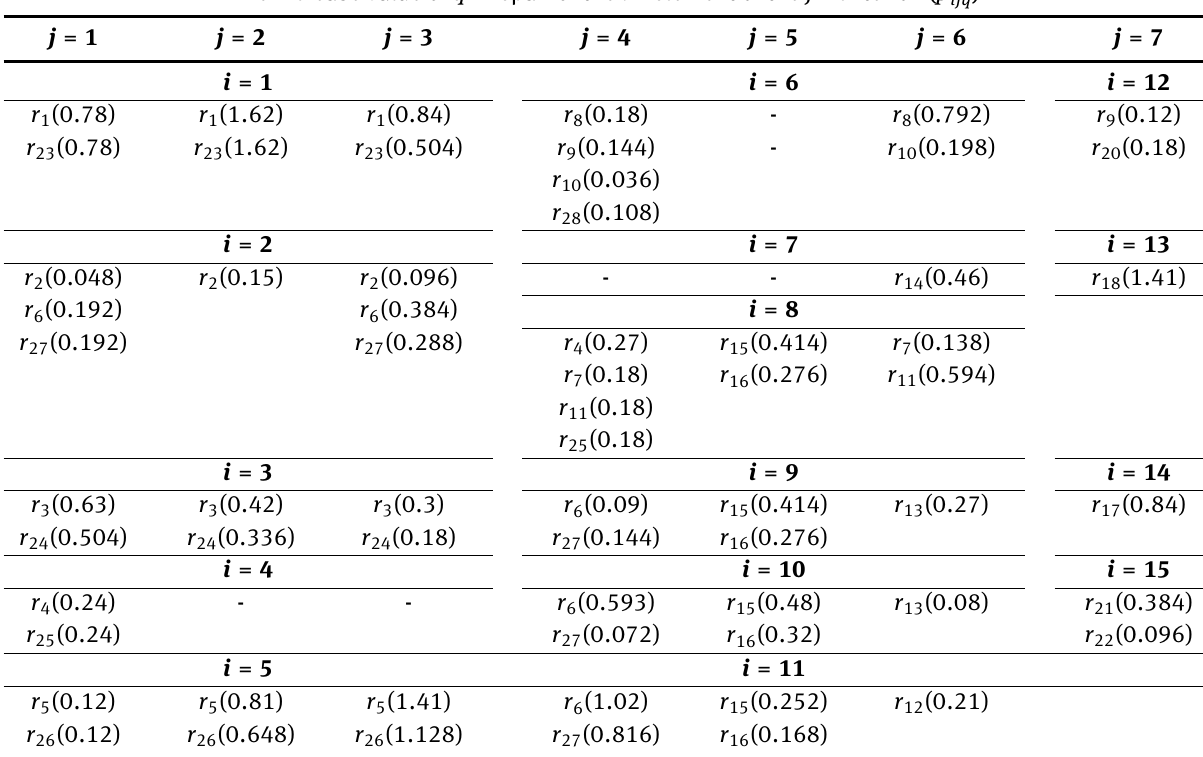
Table 5: Evaluation of criteria assessment values increase of proposed repairs The increase value of q th repair of the i th element of the j th criterion ( p ijq )